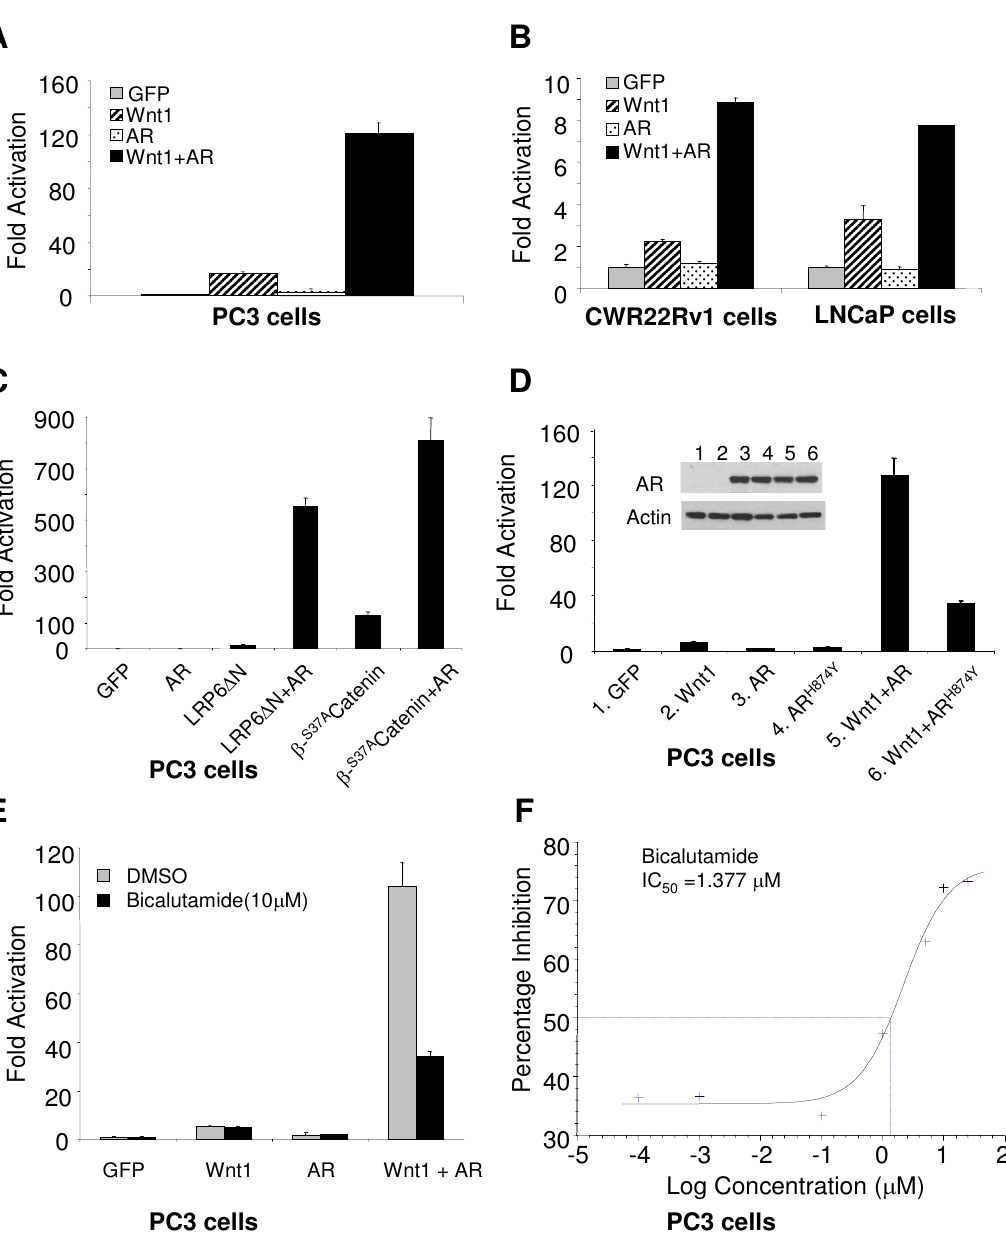
Figure 1 The overexpression of wild-type or mutant AR potentiates Wnt signaling . Cells grown in RPMI with 10% FBS were transiently transfected with indicated plasmids together with LEF-luciferase and pCMV-Renilla reporter constructs in 12 well plates. Cotransfection of Wnt1 and AR leads to a synergistic effect on the activation of LEF-luciferase reporter in PC3 cells (A), CWR22Rv1 and LNCaP cells (B), compared with transfection with Wnt1 alone. The AR can also potentiate the activation of Wnt signaling in cells expressing a constitutively activated human receptor LRP6, truncated at the N terminus (H6 Δ N), or a stabilized β -Catenin S37A (C). The synergistic effect between AR mutants and Wnt1 signaling is shown (D). AR expression levels were measured for both wild type and mutant AR H874Y . Actin levels were used as loading controls. The effect of an AR antago- nist is shown (E & F). PC3 cells were treated with bicalutamide 4 hours after transfection. Dual luciferase assay was performed 20–24 hours after